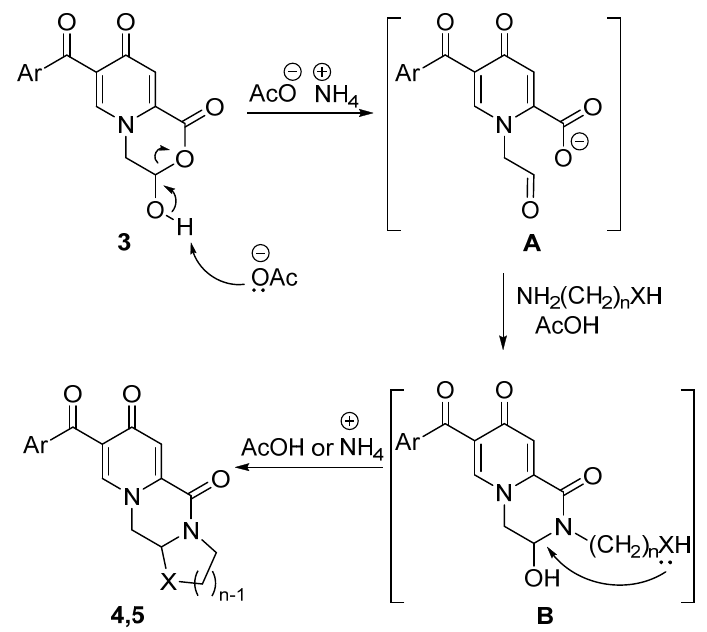
Scheme 3. The proposed mechanism of the ring ‐ opening transformation.